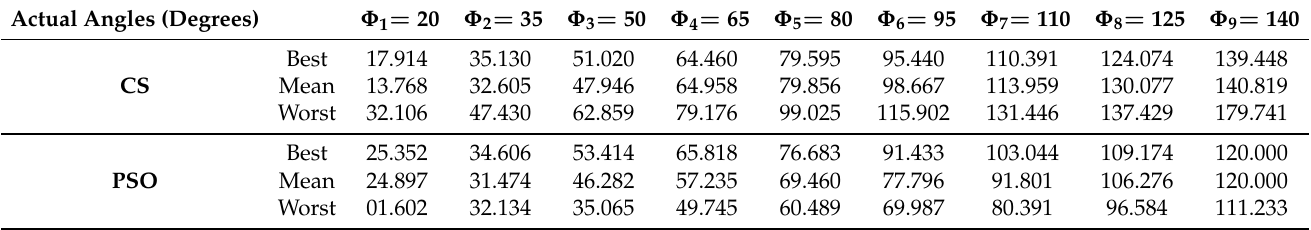
Table 6. Calculation of accuracy for nine targets at − 10 dB SNR.